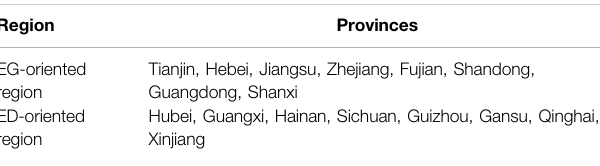
TABLE 3 | Provinces in different regions. Region